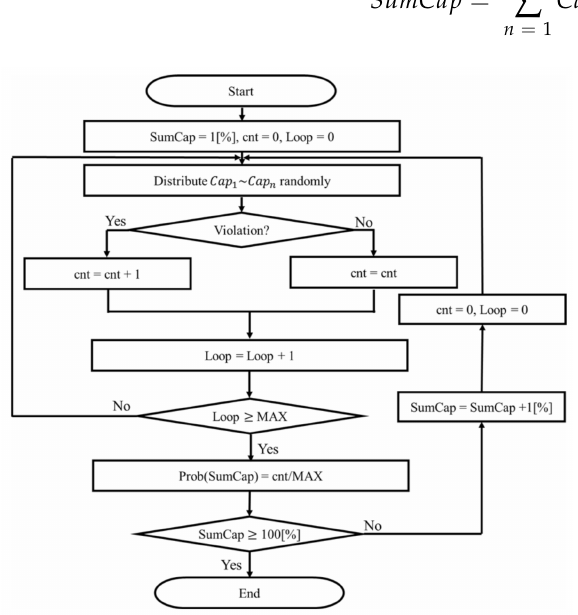
Figure 1. Flowchart for the hosting capacity computation method using the Monte-Carlo simulation.